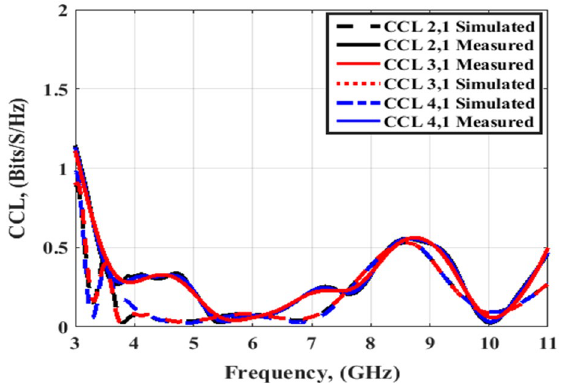
Figure 27. Port #1 CCL simulated and testing outcomes of the flexible MIMO antenna in bending configuration with R = 45 mm.